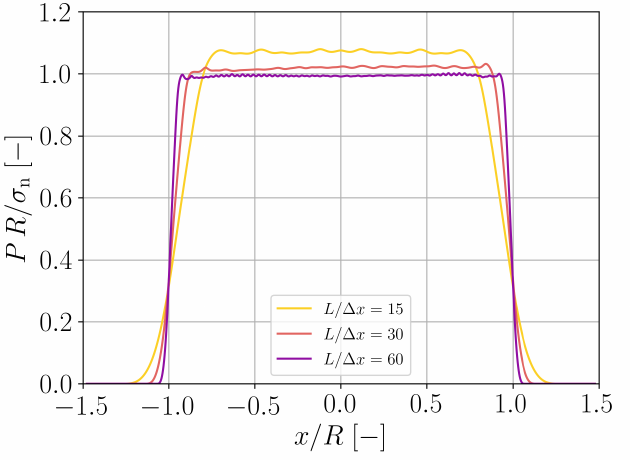
Figure 6. Pressure distribution in the formed droplet as a function of the lateral coordinate at y = 0 for different spatial